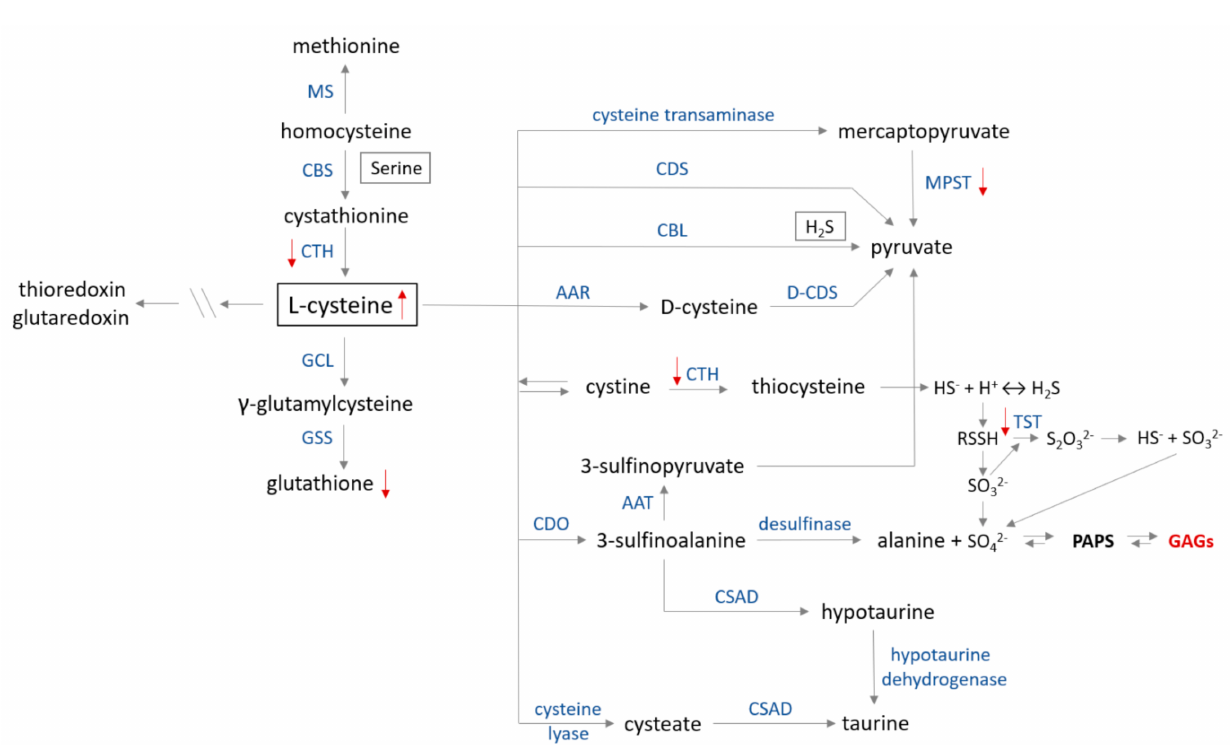
Figure 6. Cysteine metabolism map. The catabolism of cysteine involves seven pathways pro- ducing pyruvate, hydrogen sulfide, alanine or taurine. (1) In the first step, cysteine is con- verted to mercaptopyruvate in deamination reaction catalyzed by cysteine transaminase (CGT, EC 2.6.1.3). Subsequently, mercaptopyruvate is changed to pyruvate on the trans-sulfuration way by 3 − mercaptopyruvate sulfurtransferase (MPST, EC 2.8.1.2)—the ‘mercaptopyruvate